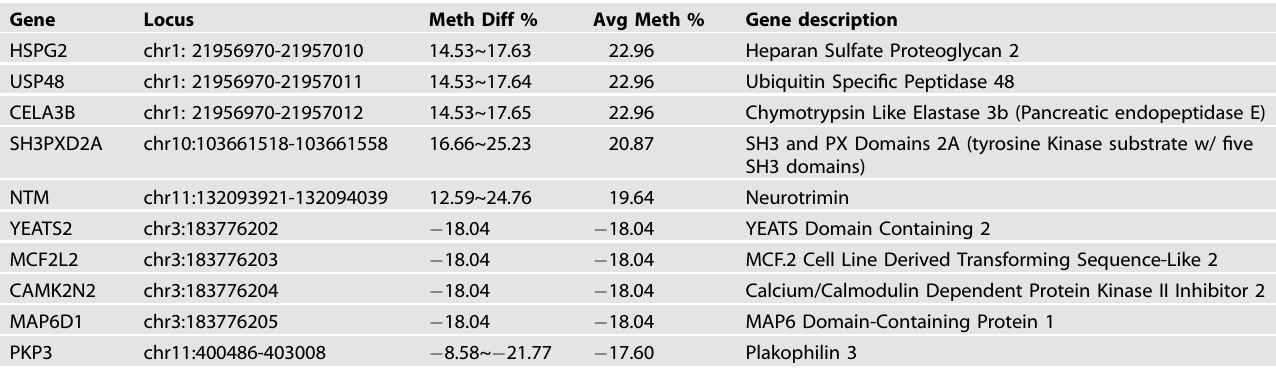
Table 3. List of Top 10 differentially methylated genes.